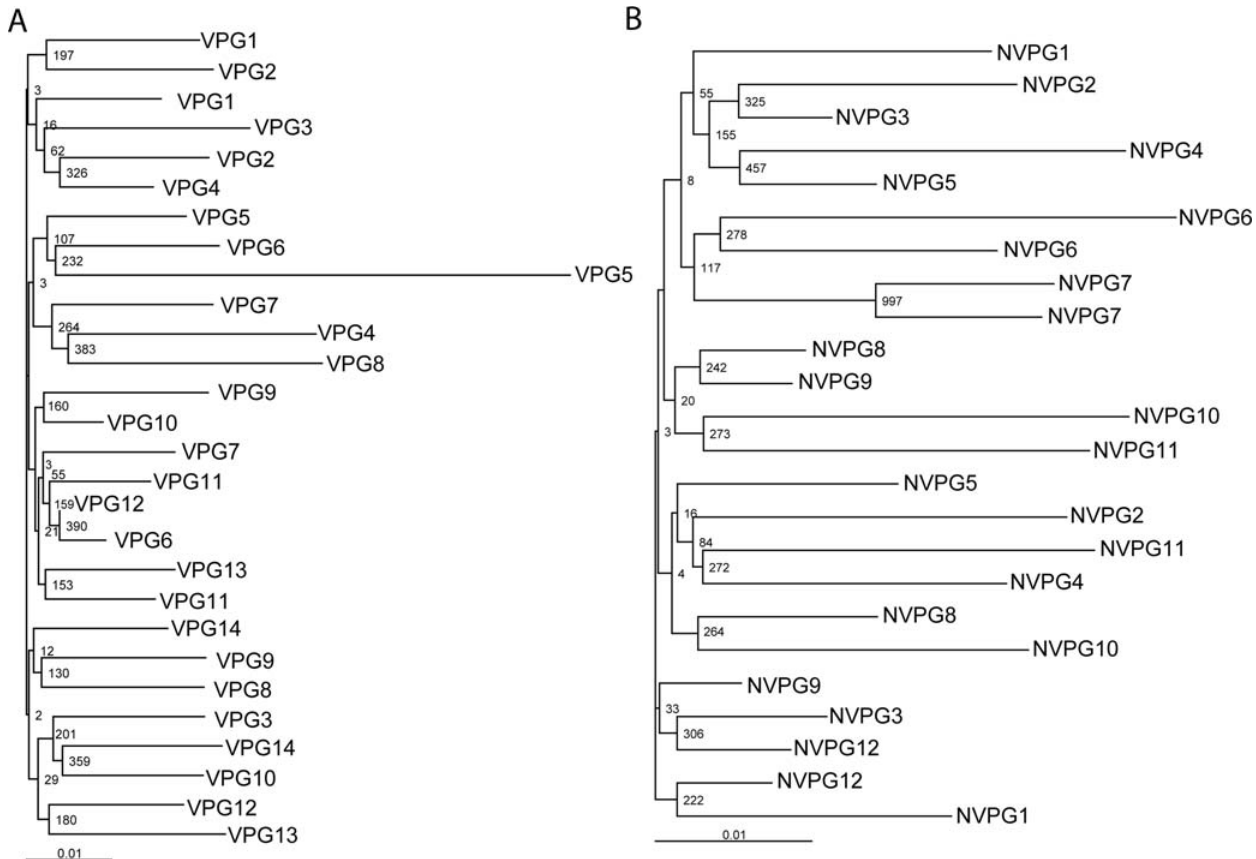
Figure 8. Phylogenetic analysis showed no evidence for systemic super-infection. No individuals studied in either the viremic partner group (A), or the non-viremic partner group (B) showed evidence of systemic super-infection by phylogenetic analysis. A unique partnership number indicates each partnership. No bootstrap values above 70% (indicated at each branch point) were generated between partner’s viral sequences taken from the same time point, indicating their viruses were significantly divergent and no super-infection had occurred. * Known infecting